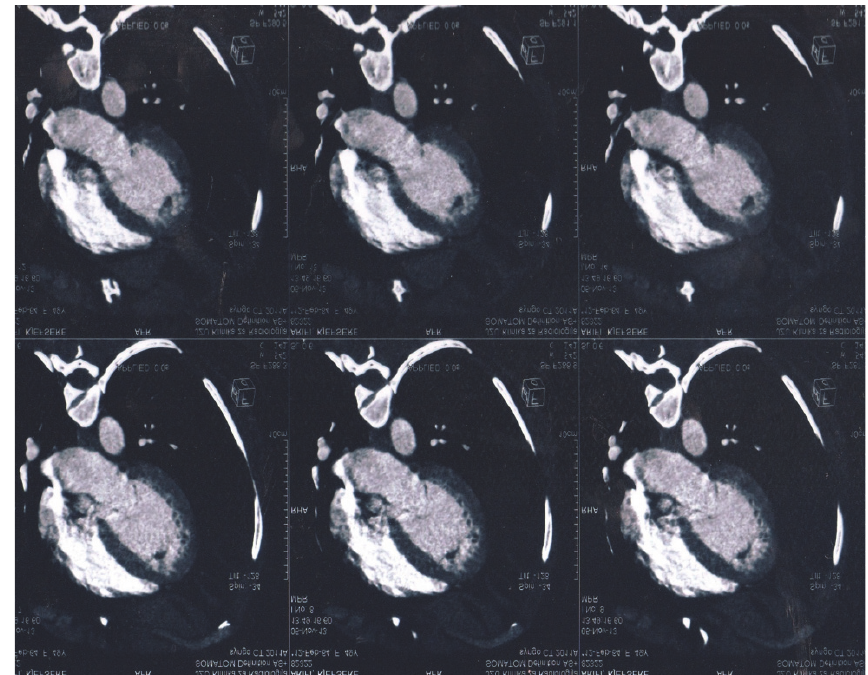
Figure 1: Left ventricular thrombus.